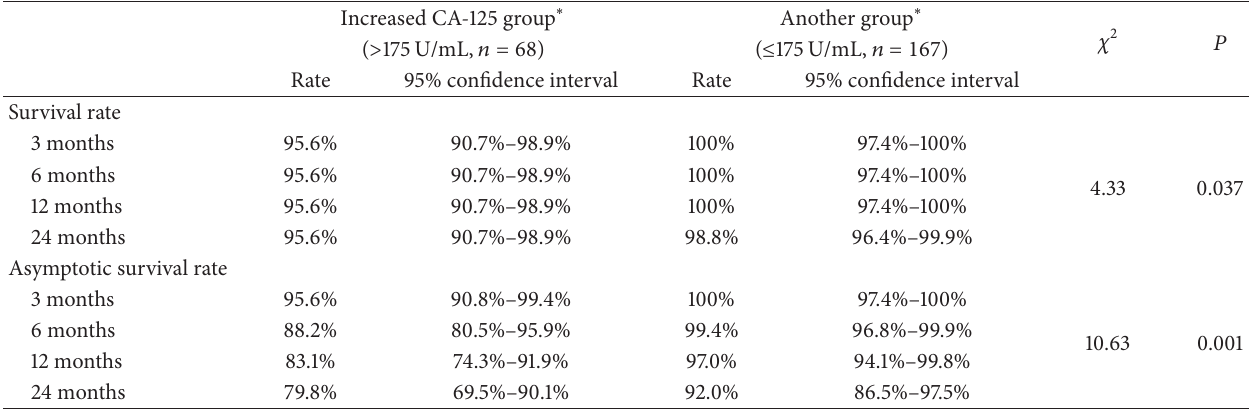
Table 4: Survival rate comparison between Budd-Chiari syndrome patients with different serum CA-125 after interventional treatment.